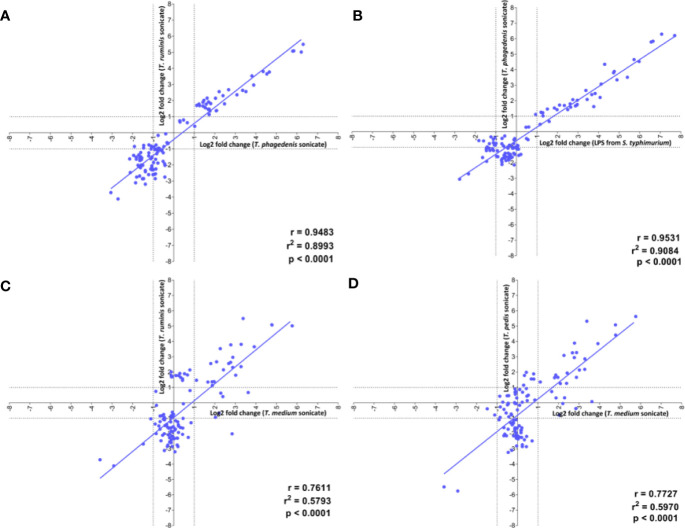
Correlation of the transcript proﬁles of primary bovine foot skin ﬁbroblasts challenged with pathogenic or commensal treponemes. Linear regression analysis was used to determine the correlation of global differential mRNA expression, represented as log2 fold change of the 20 greatest increased and decreased transcripts, between the following pairwise comparisons: (A)
T. phagedenis versus T. ruminis, (B)
S. Typhimurium versus T. phagedenis, (C)
T. medium versus T. ruminis, (D)
T. medium versus T. pedis. The regression line (gray) for each pairwise treatment comparison is shown alongside its corresponding linear correlation coefﬁcient (r), coefﬁcient of determination (r2) and p value (p), where p ≤0.05 represents statistical signiﬁcance. Data represents mean differential transcript expression of three independent experimental replicates per challenge group (n = 3), with both T. phagedenis and T. ruminis represented by an additional technical replicate (n = 4).